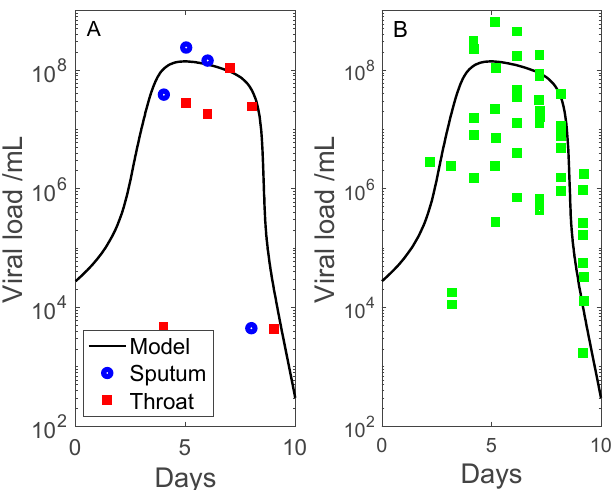
Figure 2. Time-course of viral load, given in days following onset of symptoms, taken to be 7 days following initial viral exposure. Panel ( A ) includes sputum (blue) and throat swab (red) sample data collected by Pan et al. [15]. Panel ( B ) includes sputum viral loads measured by Wolfel et al. [14] in multiple patients (green dots).